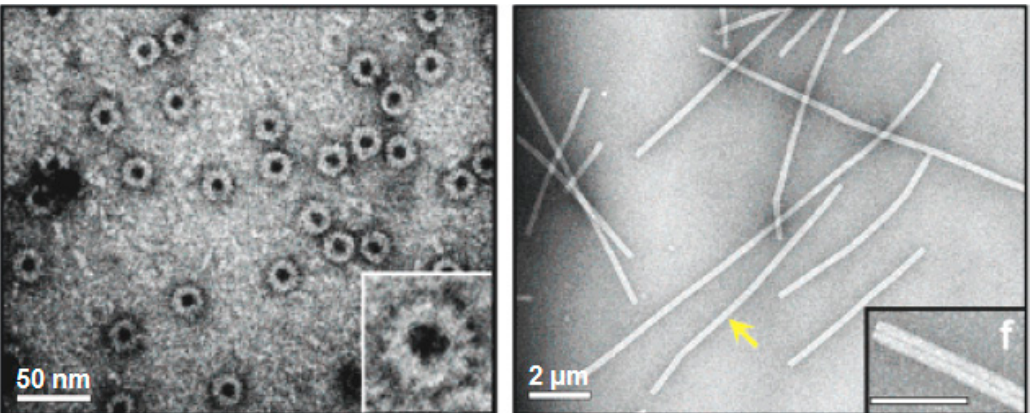
Figure 3. Viral protein-based nanodisks and nanotubes. TEM images of chromophore containing nanodisks ( left ) and nanotubes ( right ) produced from a modified tobacco mosaic virus (TMV) coat protein [69]. The scale bars represent 50 nm ( left ) and 200 nm ( right ). The yellow arrow is pointing to a single 900-nm-long TMV PNT containing over 6300 chromophore molecules. (Reprinted with permission from Miller et al. J. Am. Chem. Soc . 129 , 3104-3019 (2007) [69]).